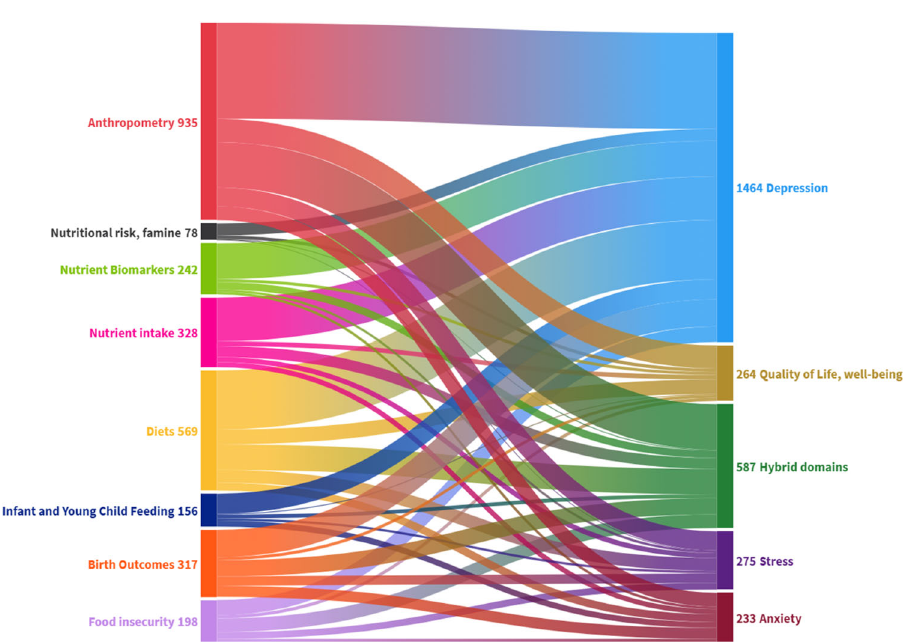
Fig.3|Sankeydiagramofthenumberofstudieslinkingfoodsecurityandnutrition(FSN)tomentalhealth(MH). CategoriesofFSNmeasuresontheleftarelinkedto corresponding groups of MH measures listed on the right, with the width of the bands indicating the proportional number of studies connecting the